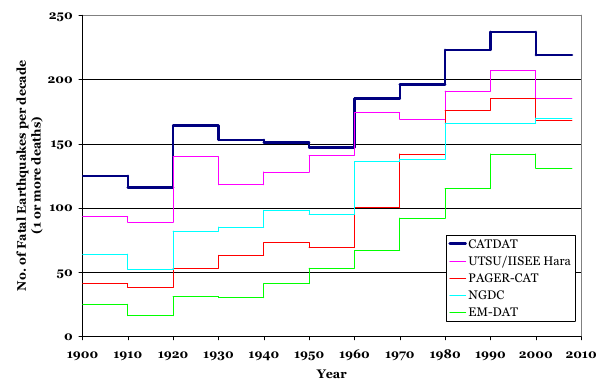
Fig. 7. The number of fatal earthquakes per decade (up to 2008) in each of the major international earthquake databases as compared to CATDAT Damaging Earthquakes v4.12 (Daniell,